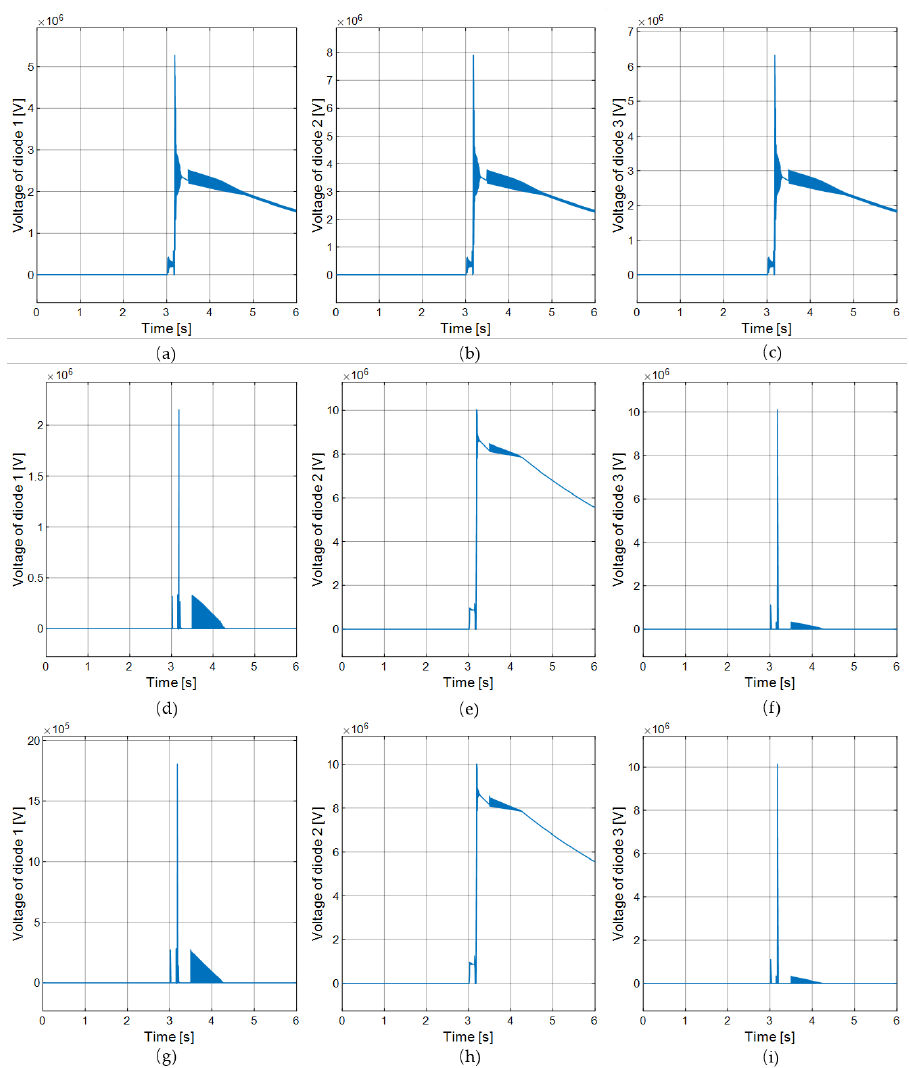
Figure 11. The diode voltage distribution under different constraints: ( a ) Junction capacitance C 1 = C 1 = 6 µ F; ( b ) junction capacitance C 2 = 4 µ F; ( c ) junction capacitance C 3 = 5 µ F; ( d ) Q rr1 = 4500 µ C; 6 μF; ( b ) junction capacitance C 2 = 4 μF; ( c ) junction capacitance C 3 = 5 μF; ( d ) Q rr1 = 4500 μC; ( e ) Q rr2 ( e ) Q rr2 = 4000 µ C; ( f ) Q rr3 = 5000 µ C; ( g ) junction capacitance C 1 = 6 µ F, Q rr1 = 4500 µ C; ( h ) junction = 4000 μC; ( f ) Q rr3 = 5000 μC; ( g ) junction capacitance C 1 = 6 μF, Q rr1 = 4500 μC; ( h ) junction capaci- tance C 2 = 4 μF, Q rr2 = 4000 μC; ( i ) junction capacitance C 3 = 5 μF, Q rr3 = 5000 μC. capacitance C 2 = 4 µ F, Q rr2 = 4000 µ C; ( i ) junction capacitance C 3 = 5 µ F, Q rr3 = 5000 µ